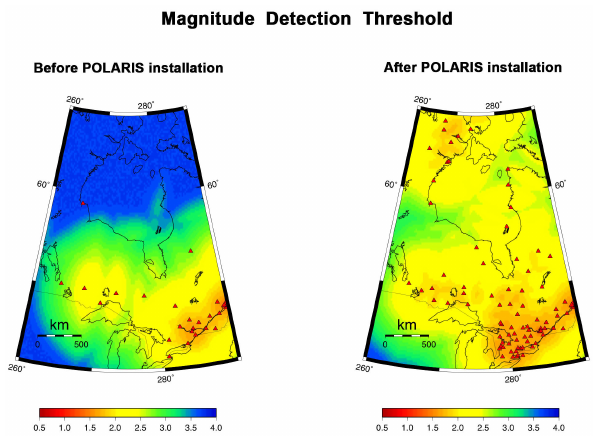
Fig. 12. Calculated magnitude detection threshold for two scenar- ios. (a) Before installation of POLARIS seismograph stations; (b) after installation of POLARIS seismograph